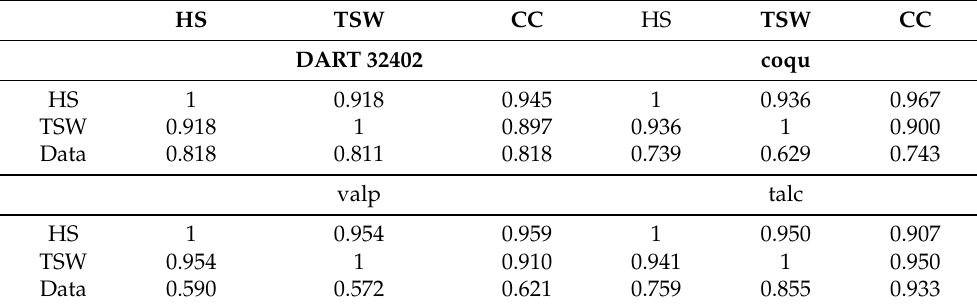
Table 4. Correlation coefficients of the time series in Figure 5 for Experiment 2015. The following abbreviations are used—HS: HySEA; TSW: TsunAWI; CC: COMCOT. Refer to Figure 1 for the tide gauge and DART locations.